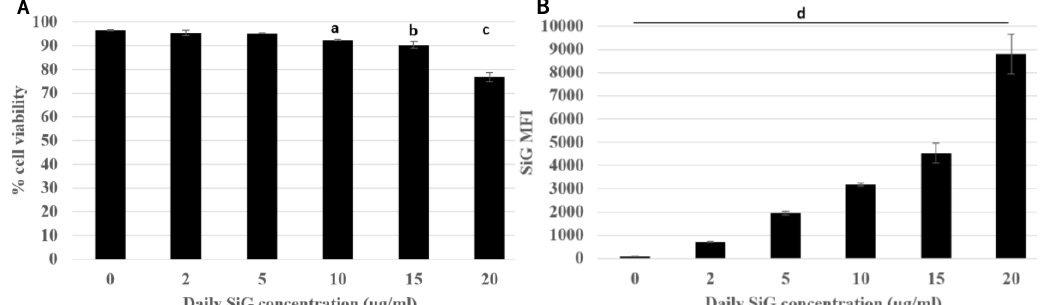
Figure 1. Green silica internalization and viability of RAW264.7 cells after an acute exposure. Green silica MFI obtained with BD Facs Melody flow cytometer. ( A ) Cell viability of exposed cells (a: Control versus acute 10 µg/mL, p value < 0.01; b: control versus acute 15 µg/mL, p -value < 0.05; c: Control versus acute 20 µg/mL, p value < 0.01). ( B ) SiG mean fluorescence intensity depending on NP concentration, (d: all the conditions are significantly different from the control p -value < 0.05). The figure represents the duplicate means of three independent experiments, n = 6.